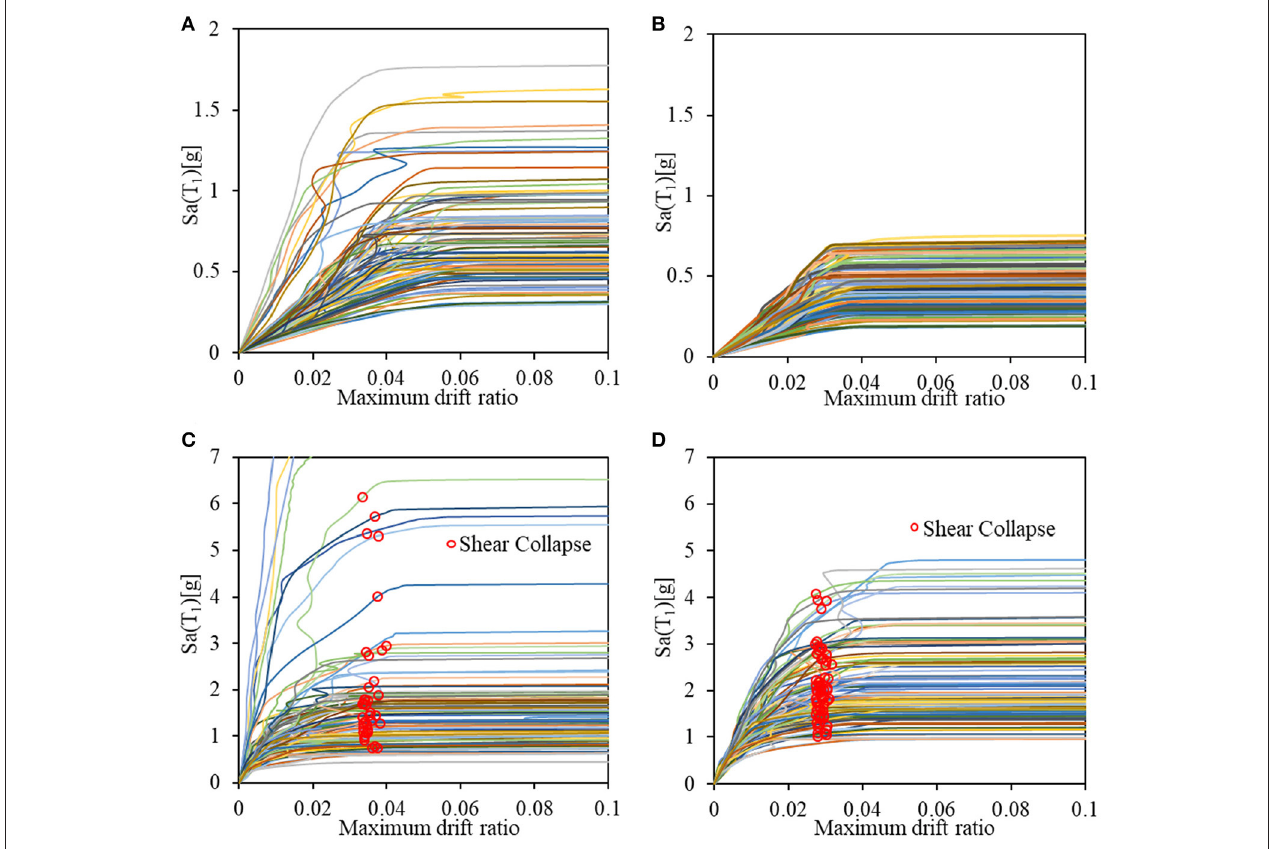
FIGURE 6 | Incremental dynamic analysis curves for 3-story buildings; (A) 3S_D_NI, (B) 3S_MD_NI, (C) 3S_D_I, and (D)